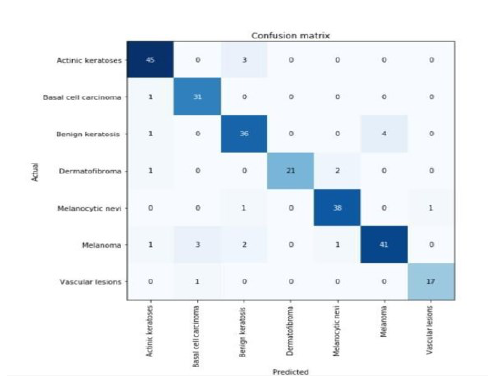
Figure 4.5: Accuracy assessment of the predicted